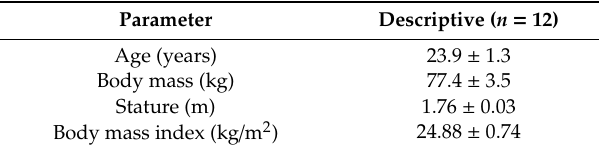
Table 1. Descriptive information on the study